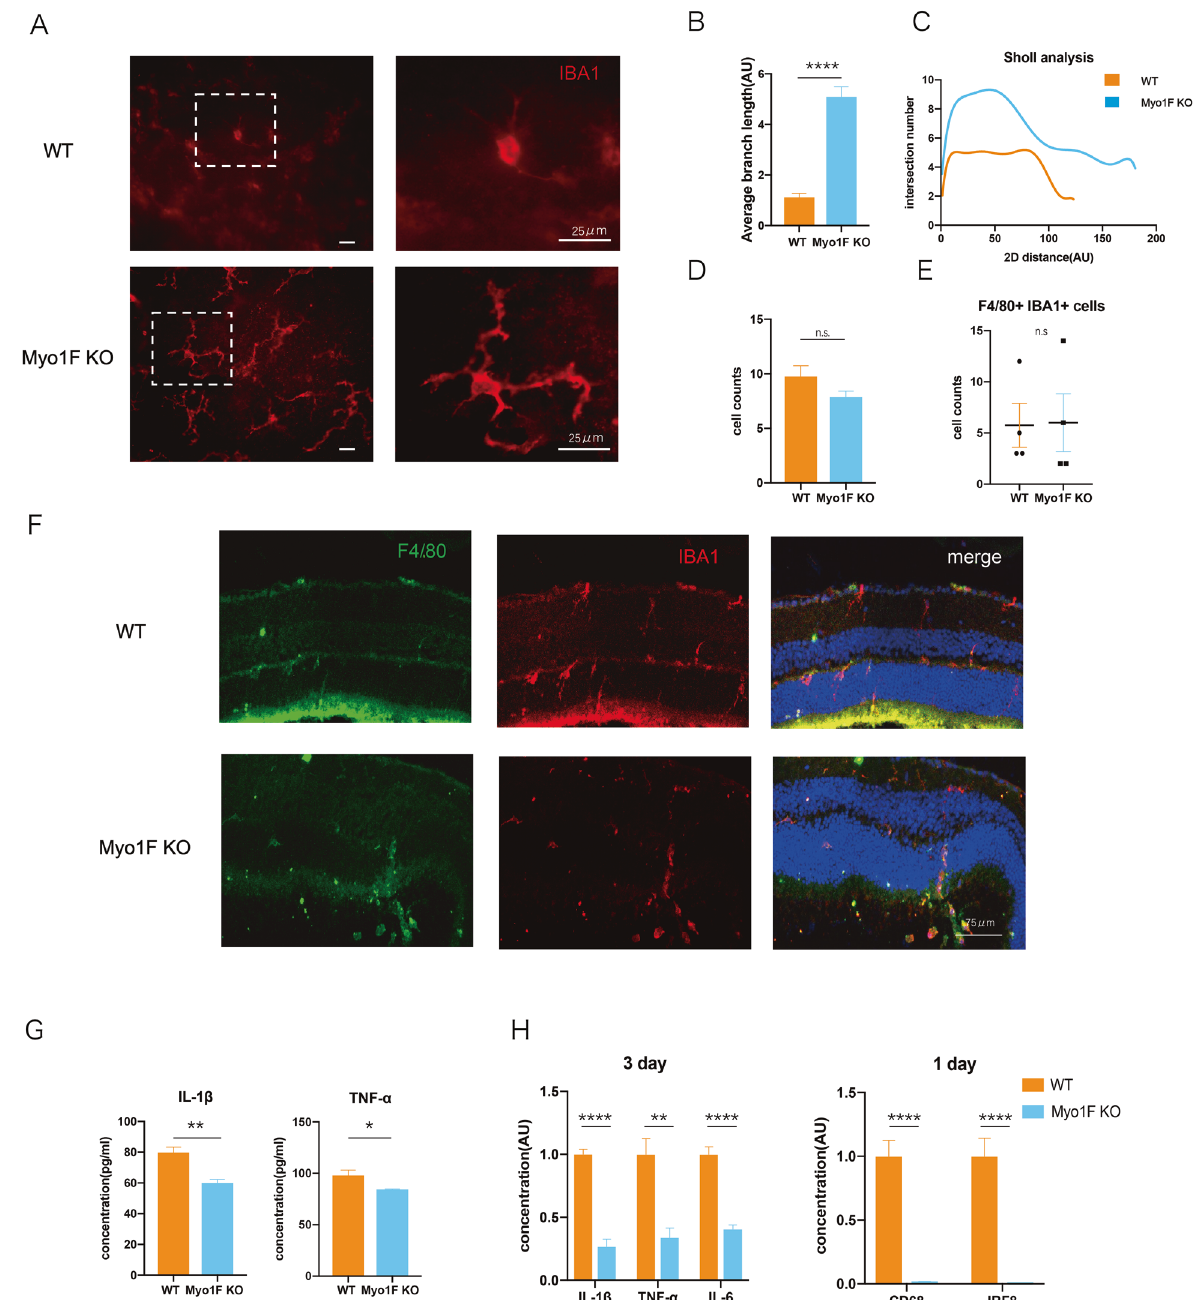
Fig. 4 Knockout of myosin 1f affects the function of microglia. A Flatmount of the detached retina of WT and myo1f KO mice, stained by IBA1 (in red), showed the morphology of microglia. Scale bar, 25 μ m. B , C Skeleton analysis ( B ) and Sholl analysis ( C ) were conducted to quantify microglia morphology. The less average branch length is, the more activated microglia is. Similarly, the less interaction number is, the more activated microglia is. D IBA1 + cell counts of the stretched preparation of retina after retinal detachment ( n = 8). E The cell count of both F4/80 + IBA1 + cells in fi ltrated into the outer nuclear layer ( n = 4). F Representative F4/80 + (green) IBA1 + (red) staining in ONL (3 days after induction of RD). G ELISA analysis of IL-1 β and TNF- α in the detached retina of WT and myo1f KO mice (day 3). The quanti fi cation of total protein was 0.4 μ g/ml. H QPCR analysis of IL-1 β and TNF- α in the detached retina at day 3, CD68 and IRF8 at day 1. Data were presented as mean ± SEM, unpaired t test, *P < 0.05, **P < 0.01, ***P < 0.001, ****P <